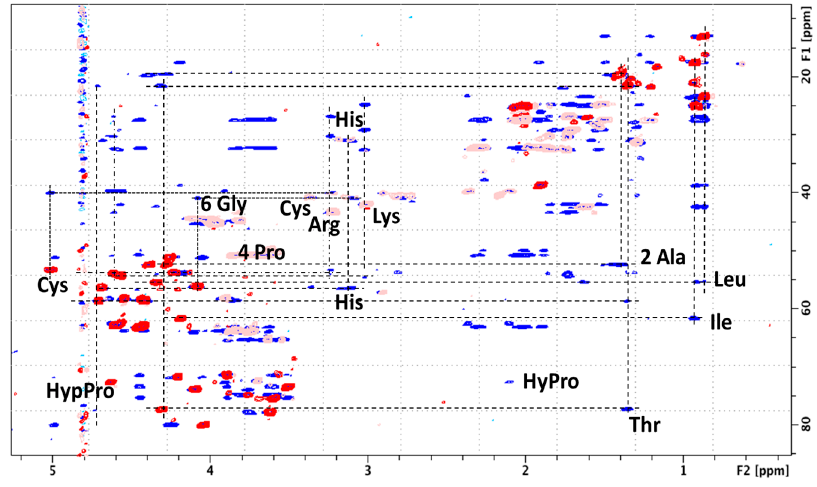
Figure 6. 2D-NMR spectra of GlycoDa-12 extract pH 4.5 (HSQC-TOCSY) in blue and GlycoDa-12 extract pH 4.5 (HSQC) in red.